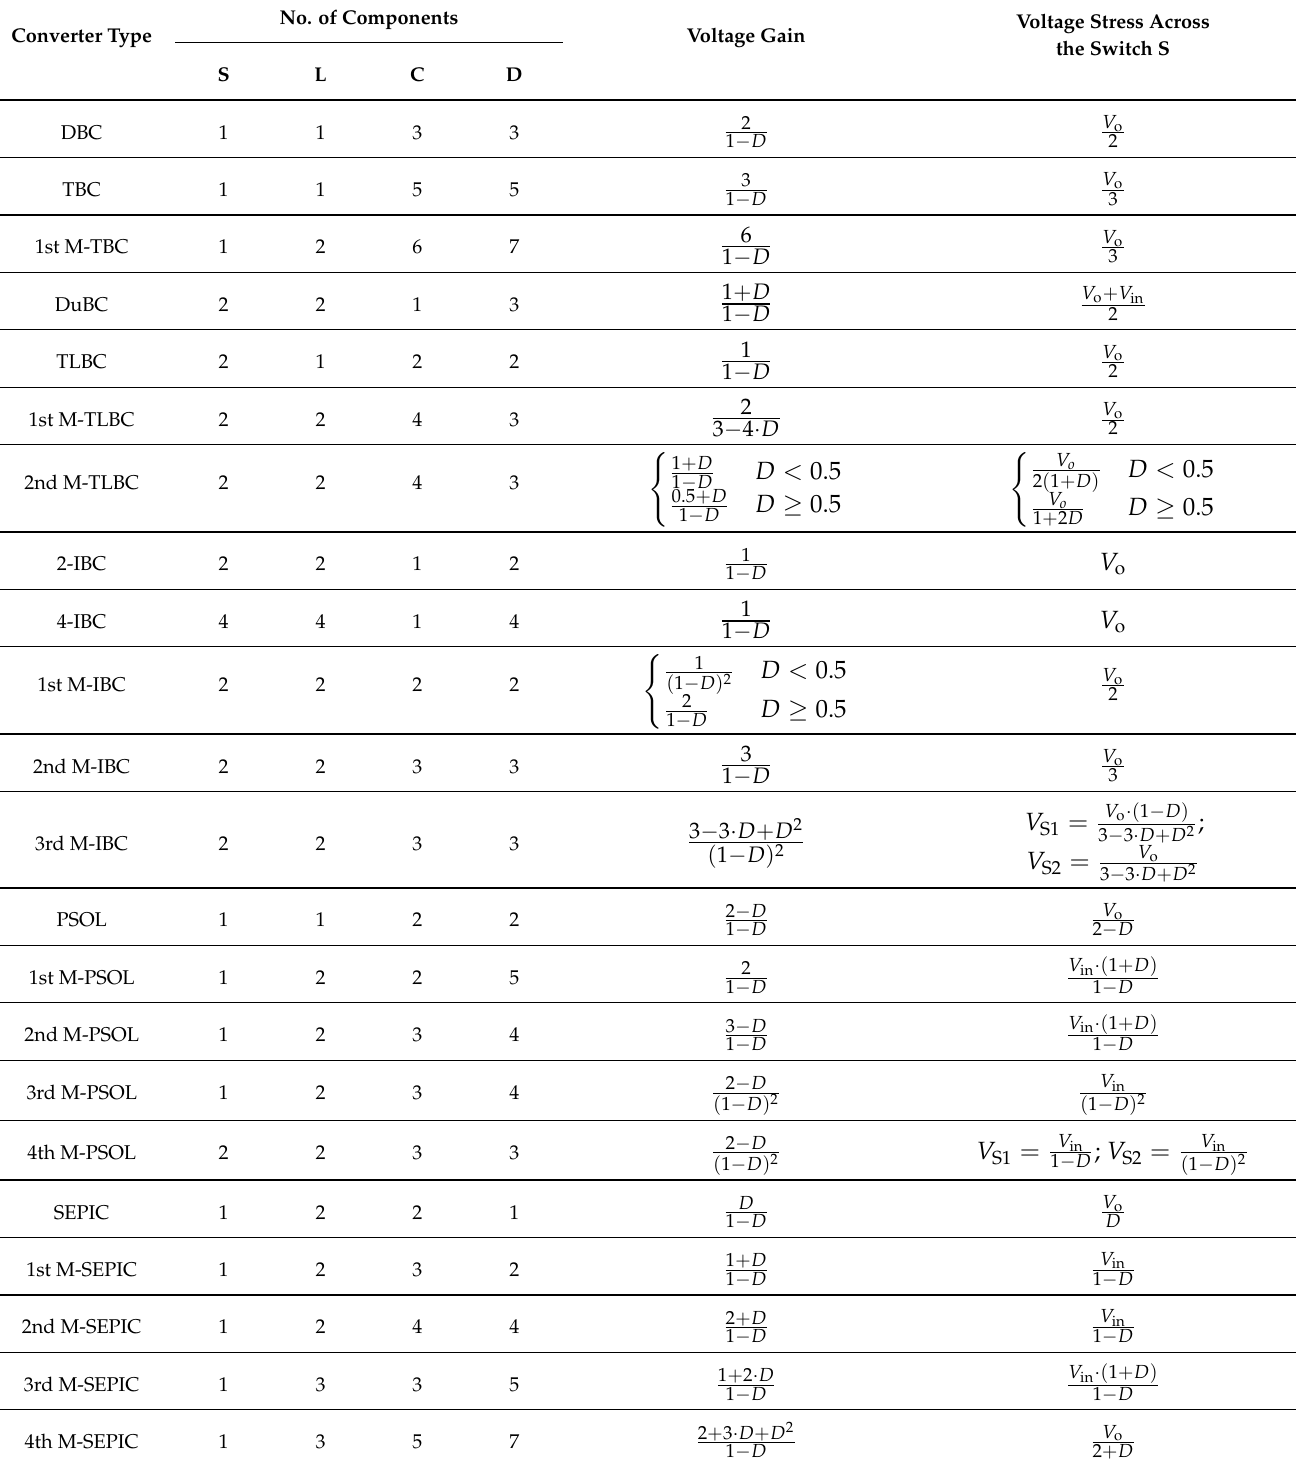
Table 2. Summary of converter